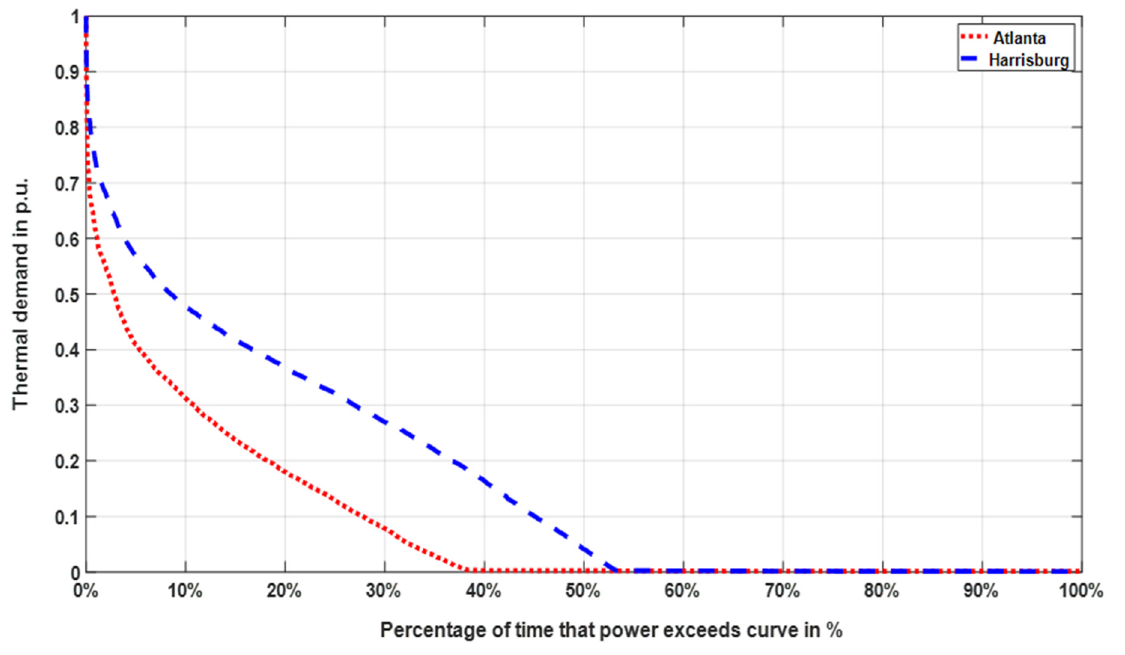
Figure 7. Comparison of thermal demand over one year in Atlanta and Harrisburg, USA.